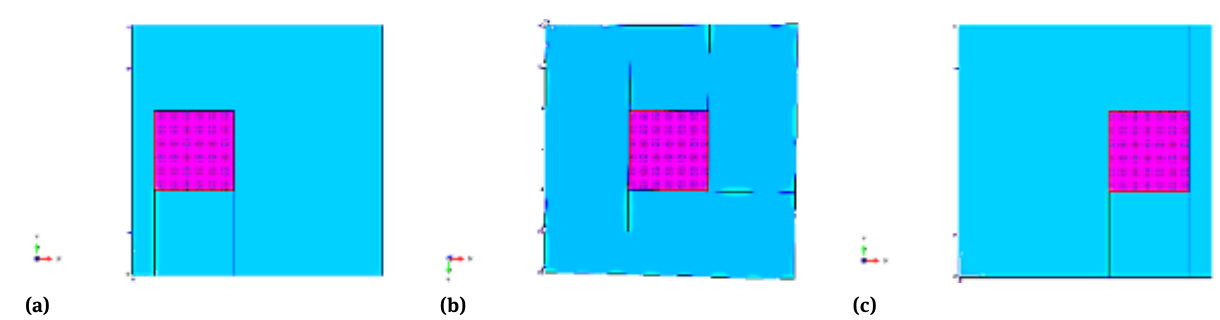
Figure 3: FEM models of ship sandwich plate with damage locations variation: (a) Location A: 10% damaged sandwich plate at 0.25 of the model length, (b) Location B: 10% damaged sandwich plate at 0.5 of the model length, and (c) Location C: 10% damaged sandwich plate at 0.75 of the model